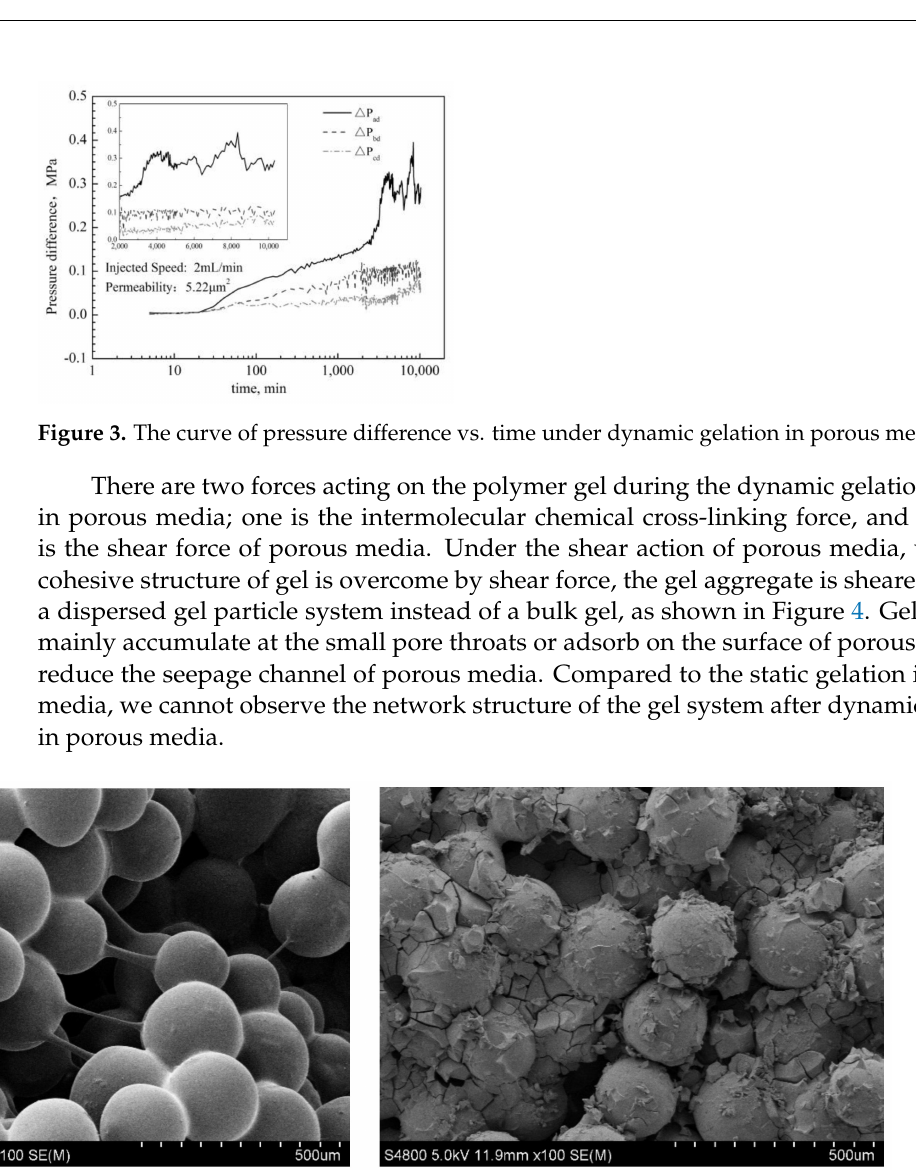
Figure 4. The micro morphology of porous media before and after dynamic gelation of PFR gel.